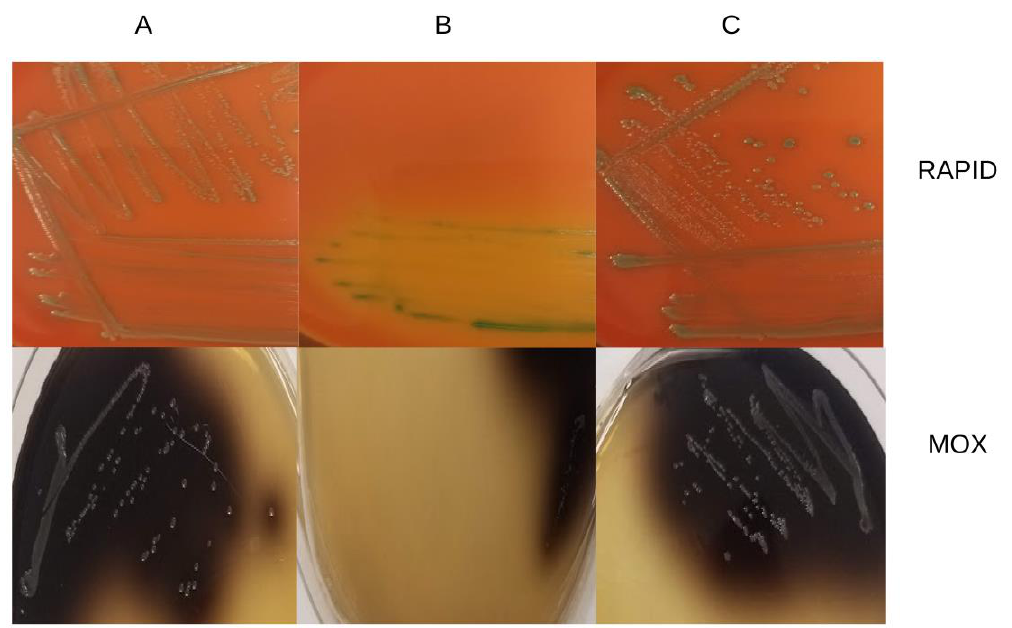
Figure 5. Growth of L. monocytogenes strains on RAPID’L.mono and MOX plates. A, parental strain 2010L-1723; B, mariner-based mutant H1H3; C, H1H3 complemented with the lmo1930 homolog. Cultures were grown at 37 °C for 48 h as described in Materials and Methods.